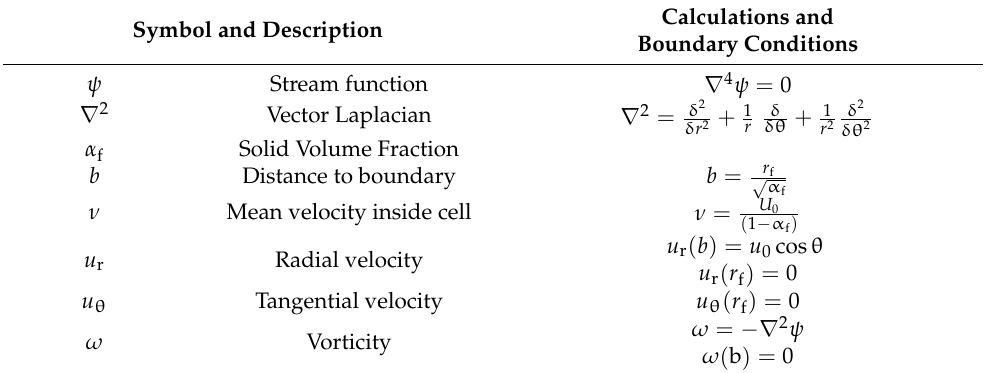
Figure A2. Kuwabara cell model for single fiber efficiency; ( a ) Kuwabara single fiber with boundary conditions; ( b ) Kuwabara flow field arrangement of fiber cross sections. Table A1. Kuwabara cell